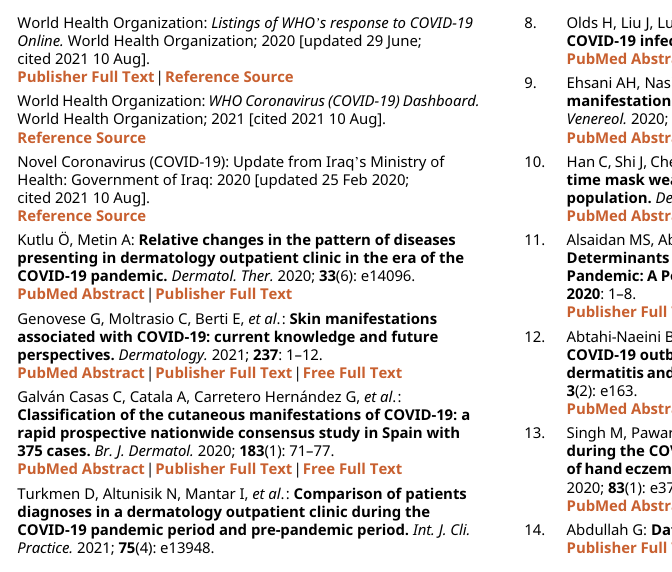
Figshare: Data_Dr_Galawish.xlsx. https://doi.org/10.6084/m9.figshare.16640476.v1. 14